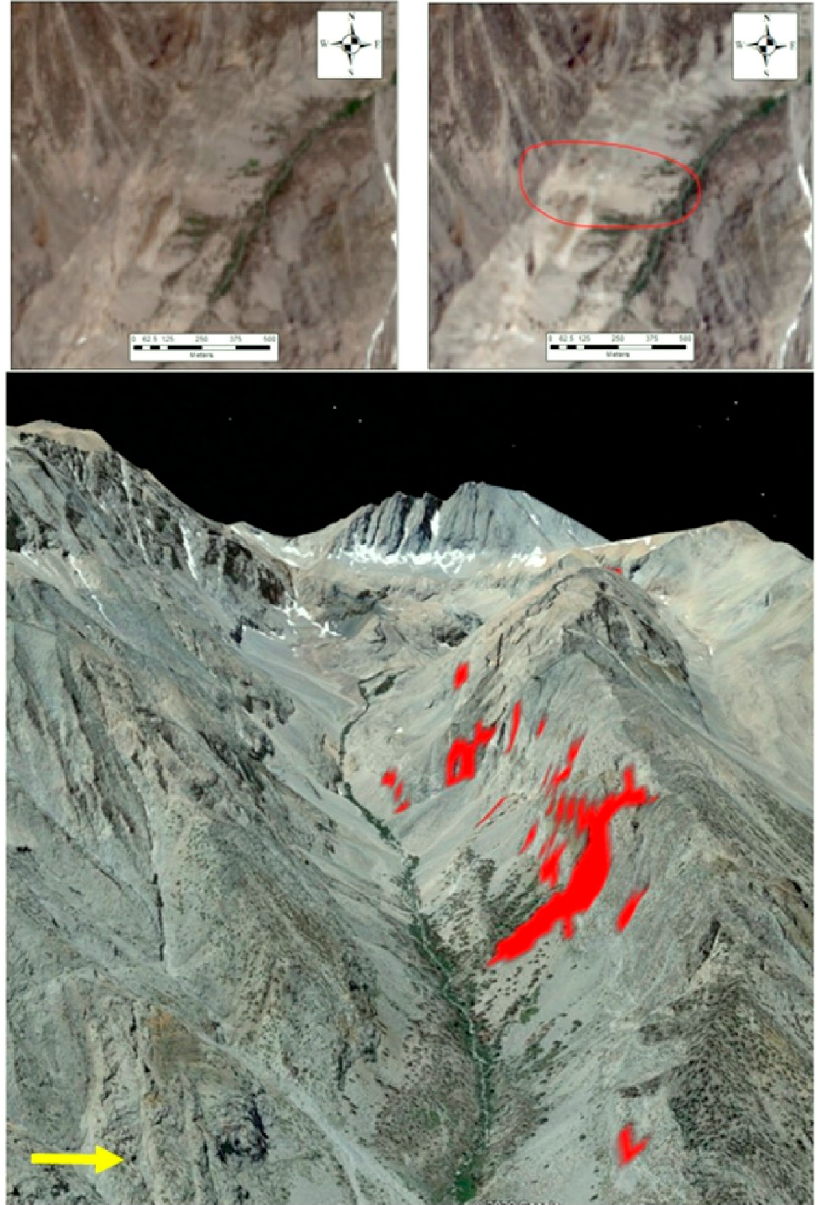
Figure 17. Williamson Canyon rockfall. Upper left : pre-earthquake Sentinel-2 image (22 June 2020). Upper right : post-earthquake Sentinel-2 image (30 June 2020) with brighter disturbed area circled. Lower : perspective view looking northwest up canyon towards Mt. Tyndall (4272 m) (Google Earth Image date July 1 2017). Red areas indicate mapped failures. The largest red polygon area corresponds to the red-circled area in upper right figure. Yellow arrow points north. Upper images ~1500 m wide. Most of the rockfalls in Upper Williamson Canyon (Figure 17) originated in a zone just below the SW/NE trending ridge crest. The source area is a 250 m high cliff face with an average angle of 55 ◦ and in places approaching 75 ◦ . Similarly to the talus slope at Grapevine Canyon in the LS study area, a 30 ◦ talus fan slopes down to the Williamson Creek below this rock face. Talus cones in both areas are slightly below the initial yield angle of repose for talus fans [77], suggesting that they are not continuously fed by new material and hence relax through weathering and creep over time (angle of rest) and only add new debris through intermittent events